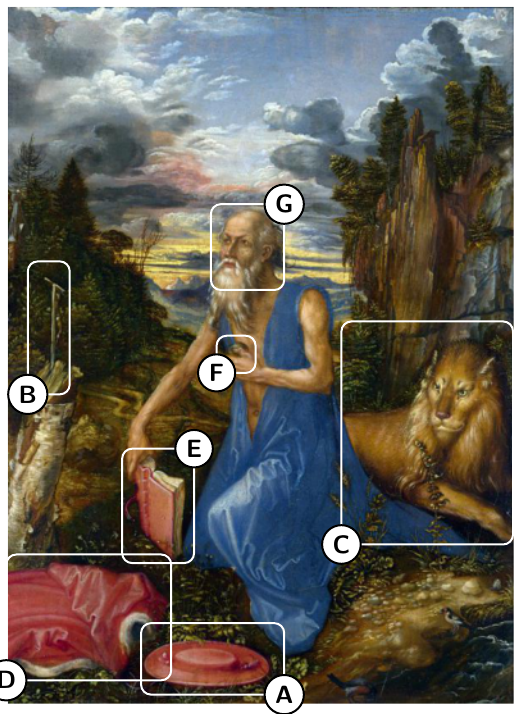
Figure 3. Saint Jerome —The cardinal’s galero ( A ), the crucifix ( B ), the lion ( C ), the cardinal’s vest ( D ), the book ( E ), the stone in the hand ( H ), and the face ( G